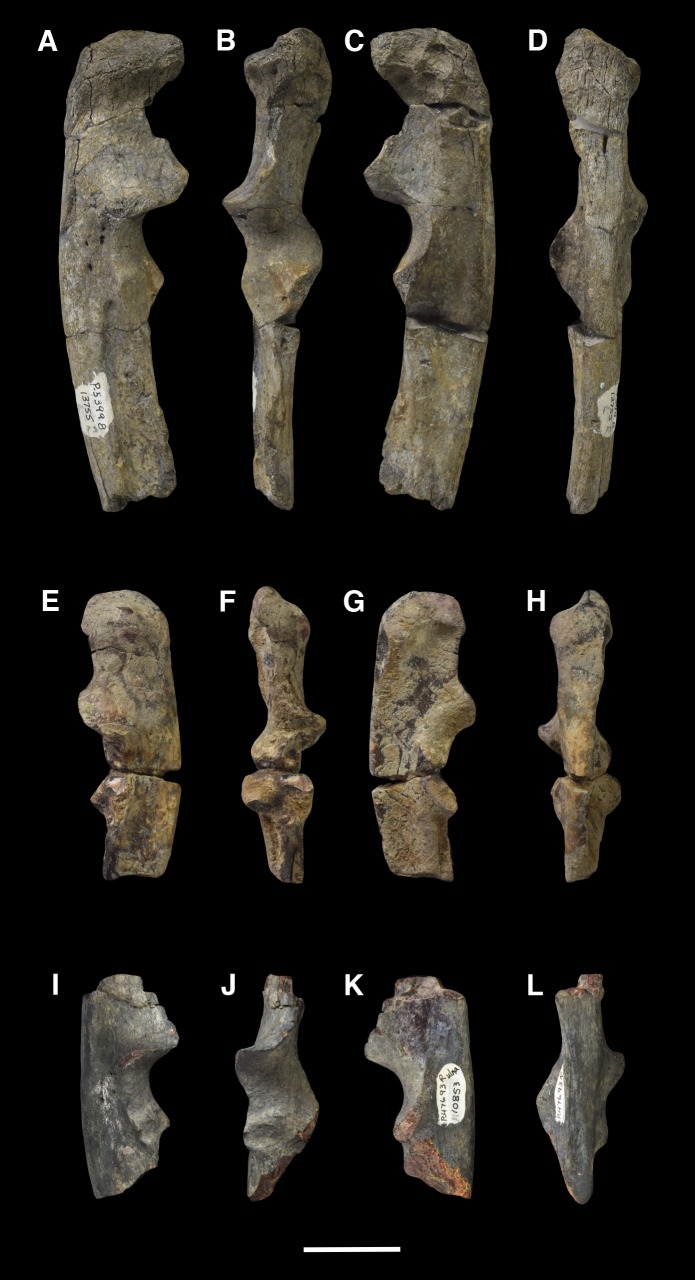
Ulnae of Periptychus carinidens.A-D: Right ulna (NMMNH P-53998): (A) lateral view; (B) anterior view; (C) medial view; (D) posterior view. E-H: Left ulna (NMMNH P35194): (E) lateral view; (F) anterior view; (G) medial view; (H) posterior view. I-L: Right ulna (NMMNH P-47693): (I) lateral view; (J) anterior view; (K) medial view; (L) posterior view. Scale bar: 30mm.